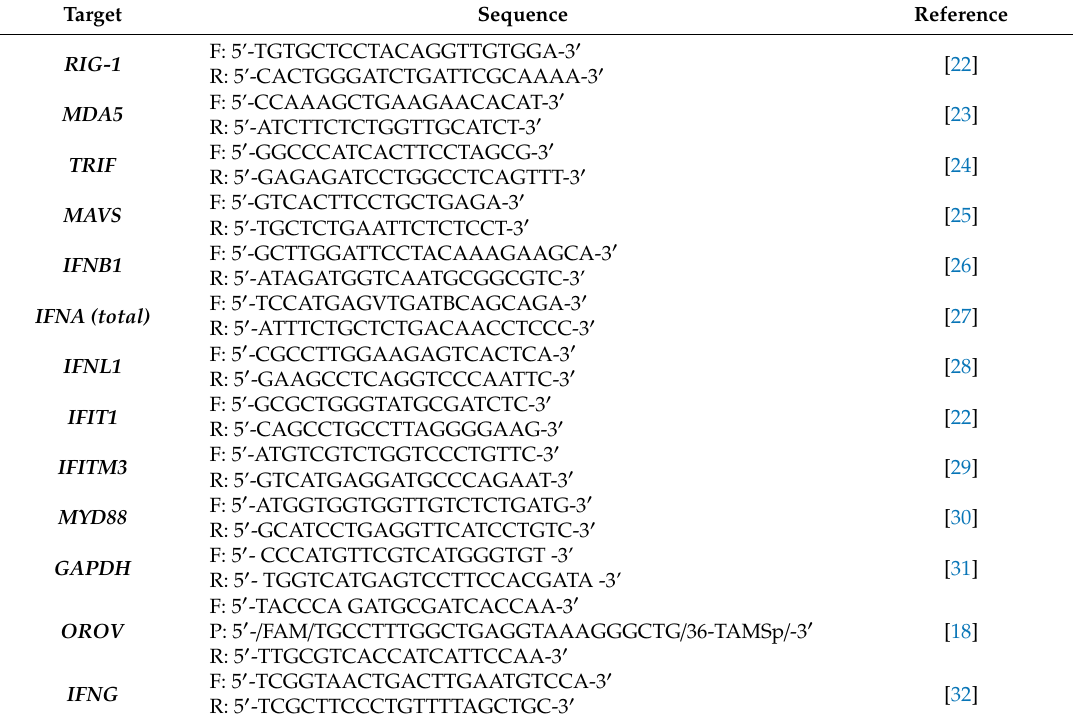
Table 1. Oligonucleotide sequences for gene expression and viral RNA